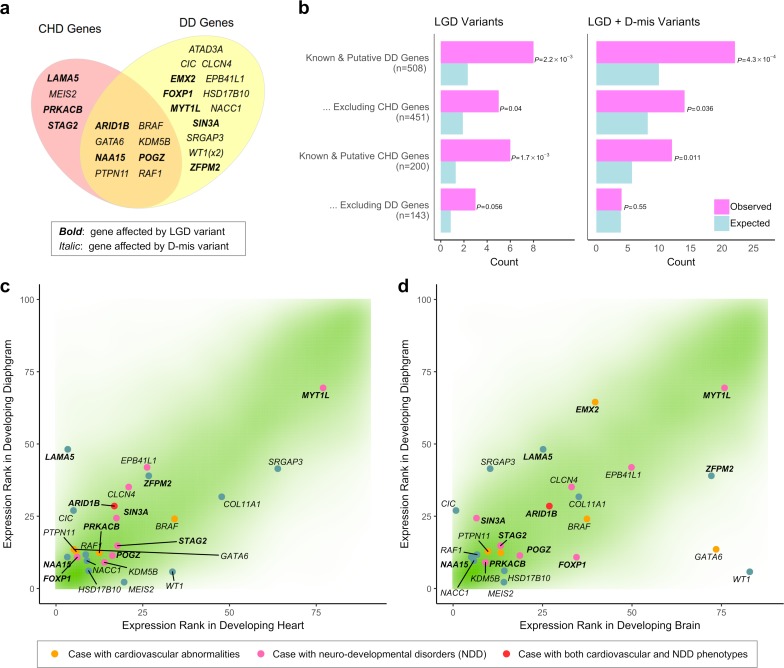
Genetic overlap with other developmental disorders.(a) Venn diagram shows 25 genes implicated in developmental disorders and congenital heart disease (DD and CHD genes, Materials and Methods) that are affected by damaging variants in CDH. (b) Enrichment of LGD and D-mis variants in DD and CHD genes. Enrichment was evaluated by comparing the observed number of de novo damaging variants in DD and CHD genes with the expected number of hits by randomly scattering the same number of variants to the exome while controlling for the number of variants, gene length, and sequence context (Materials and Methods). (c) Expression percentile ranks in the developing diaphragm [34], heart [70] and brain [70] are shown for all genes (green density), highlighting DD and CHD genes listed in (b). Smaller ranks correspond to higher expression levels.